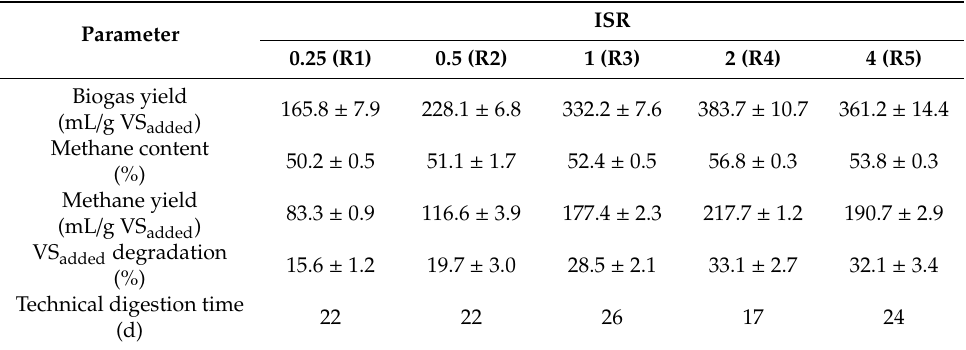
Table 3. Results from the mono-digestion of